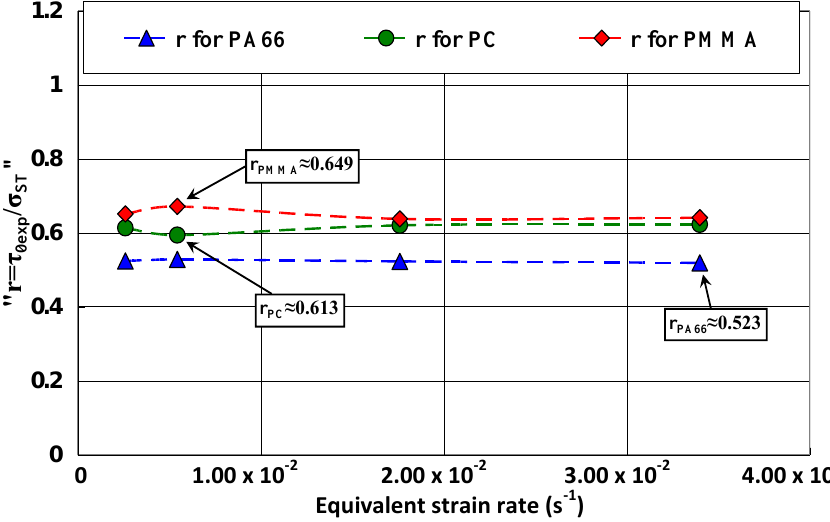
Figure 13. Relationship between yield stress and yield shear stress as a function of equivalent strain